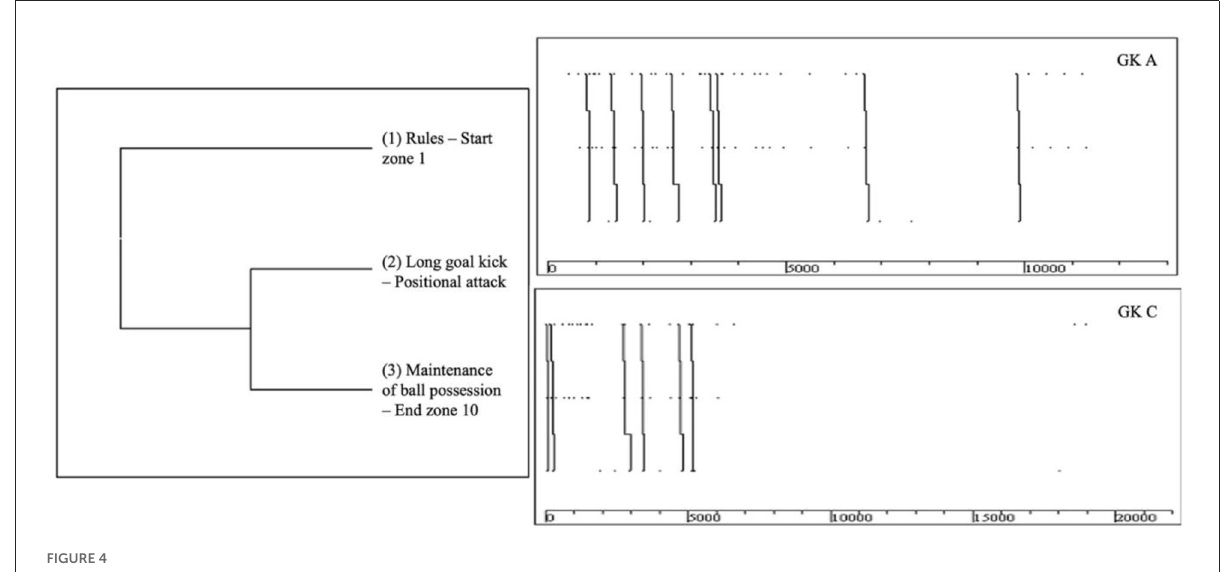
FIGURE4 T- patterns of offensive